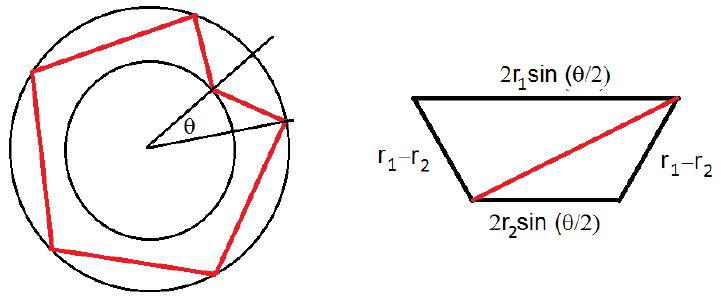
Figure 3 . The energy of a magnon stretching between the two radii is determined by the length of the diagonal of the parallel trapezium